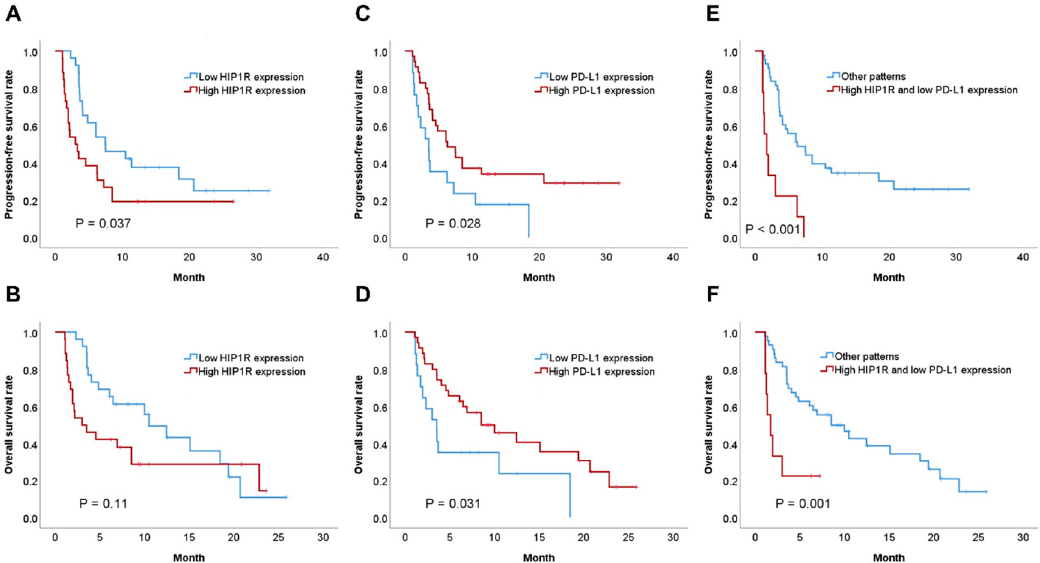
Figure 5. Comparison of survival rates according to HIP1R and PD-L1 expression. ( A ) Progression-free survival (PFS) and expression of HIP1R. ( B ) Overall survival (OS) and expression of HIP1R ( C ) PFS and PD-L1. ( D ) OS and PD-L1. ( E ) PFS, HIP1R, and PD-L1. ( F ) OS, HIP1R, and PD-L1.